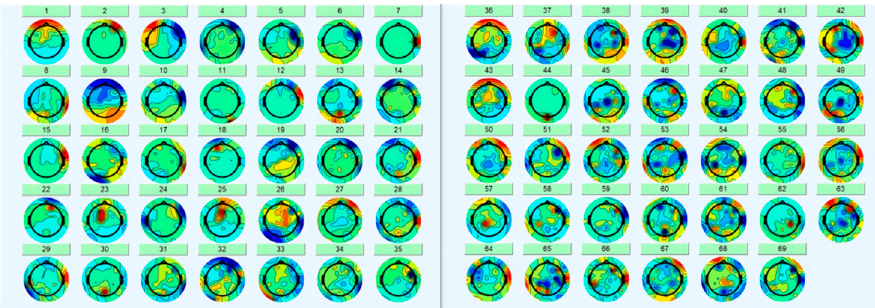
Figure 6. Topographic map of subject03 after independent component analysis.